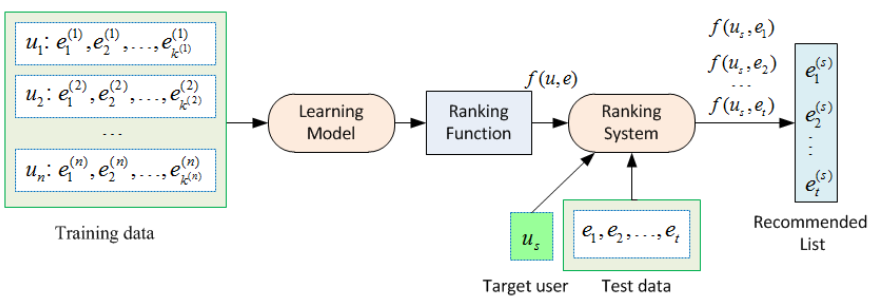
Figure 5. Process of Learning to Rank (LTR)-based